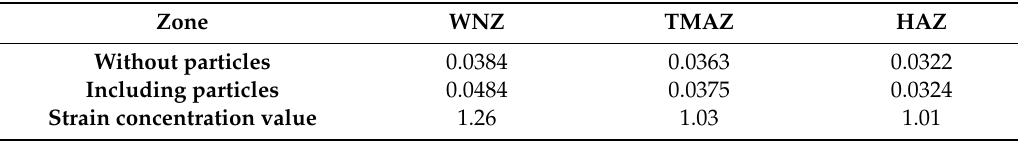
Table 5. Maximum principal strain of RVE in each zone.